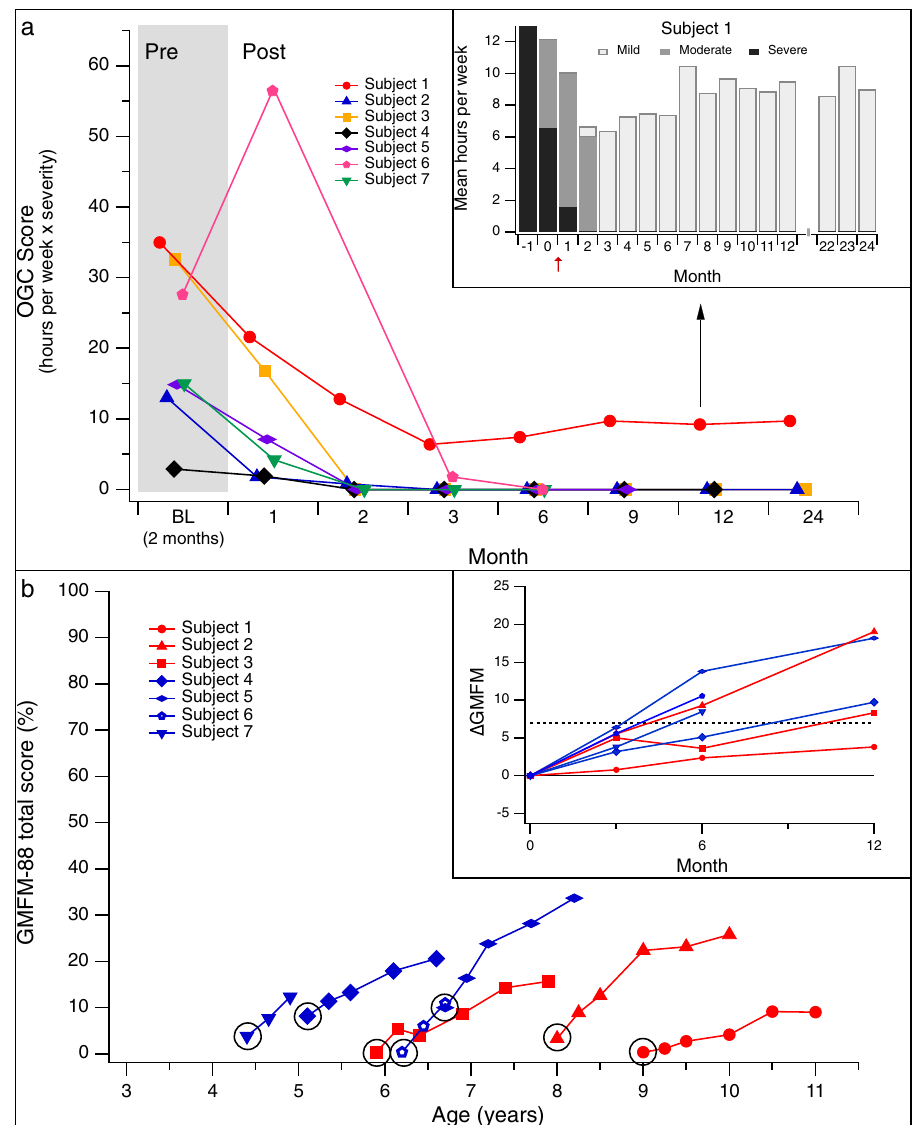
Fig. 3 Changes in Oculogyric Crises (OGC) and motor function after gene delivery. A The OGC score was calculated monthly, and represents the weekly average of the duration of episodes (hours per week), weighted by severity (grade 1 – 3: 1 = mild/eye deviation only; 2 = moderate/eye deviation + dystonia or dyskinesia of the face and/or neck; 3 = severe/dystonia or dyskinesia involving the trunk and/or limbs). By Month 3, OGCs completely resolved in 6/ 7 subjects. Inset (black arrow): Subject 1 had residual episodes throughout the 24-month study period; the severity decreased after surgery (red arrow). B Gross Motor Function Measure-88 (GMFM-88) scores for Cohorts 1 (red) and 2 (blue). Data are shown through Month 24 for Subjects 1 – 3, Month 18 for Subjects 4 and 5, and Month 6 for Subjects 6 and 7. Baseline GMFM scores for all subjects (circled) were ≤ 10, consistent with severe motor impairment. Inset: changes in GMFM score between Baseline and Month 12. An increase of ≥ 7 points (dotted line, representing a clinically meaningful positive change) was observed in 6/7 subjects by Month 12. Source data are provided as a Source Data fi